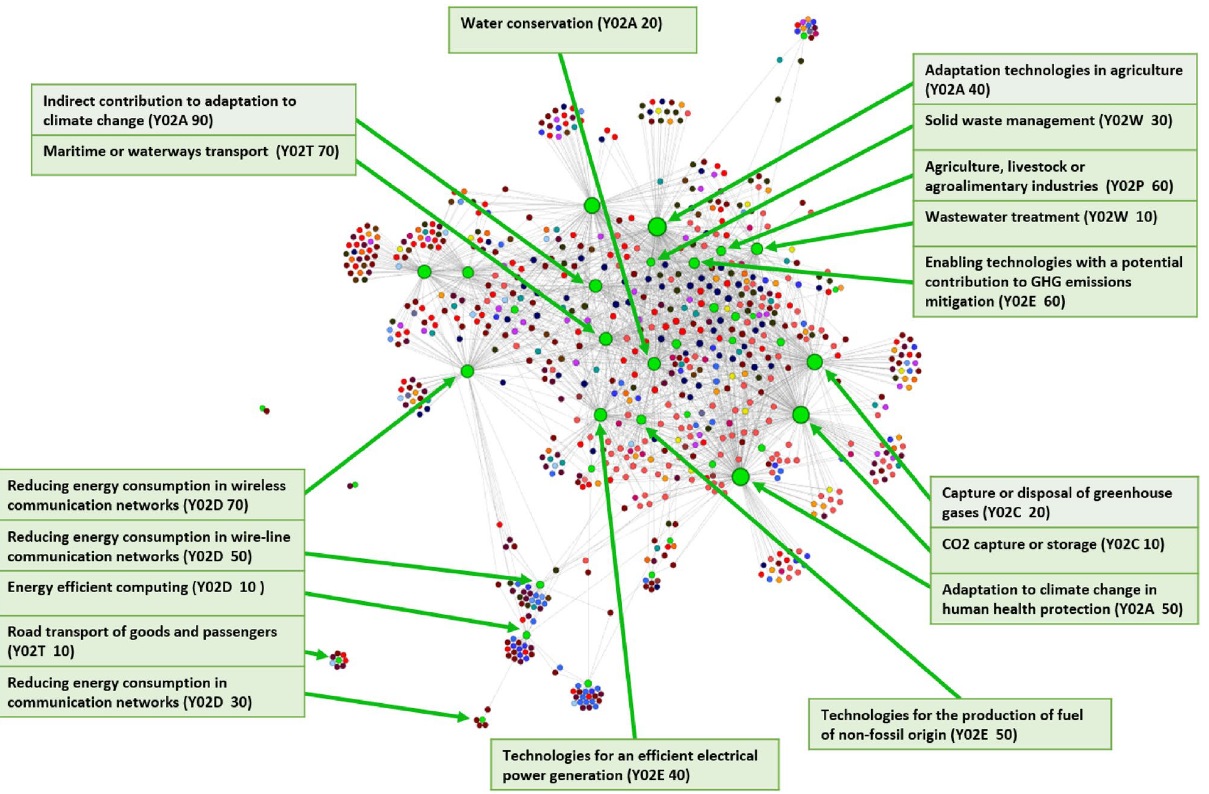
Figure 3. Directed network from green technologies to exported products for a time lag (cid:31) T = 0 and 6-digit products aggregation level. Nodes’ size is proportional to their degree. Green nodes: green technologies with green arrows pointing to the description of some of them. All other nodes: exported products (coloured according to Table